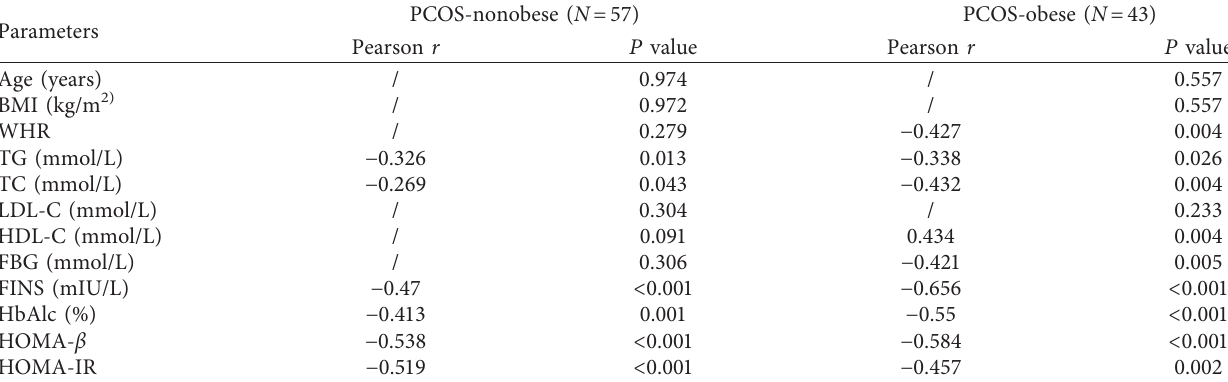
Table 3: Correlation analysis between serum miR-141-3p expression and clinical parameters in PCOS patients. Parameters